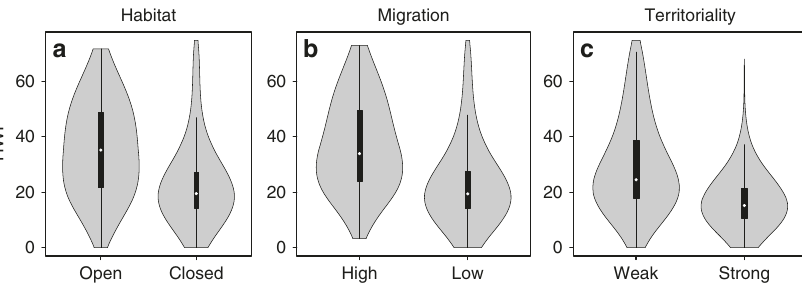
Fig. 6 Relationship between hand-wing index (HWI) and ecological variables. A global sample of bird species ( n = 9849) were classi fi ed according to ( a ) primary habitat (open grassland, deserts, shrubland, parkland, thorn forest, seashores, cities, closed forests), ( b ) migration (High >50% geographical range entirely vacated during non-breeding season, Low sedentary, elevational migrants, partially migratory, or <50% geographical range migratory), and ( c ) territoriality (weak defending territories only seasonally or never holding territories except very small lek or nest-site territories, strong defending territories year-round). Black interior boxplots show median (white dot) and fi rst and third quartile (ends of black box). Whiskers (vertical black lines) indicate data minimum and maximum excluding outliers (calculated as fi rst and third quartile ±1.5 times the inter-quartile